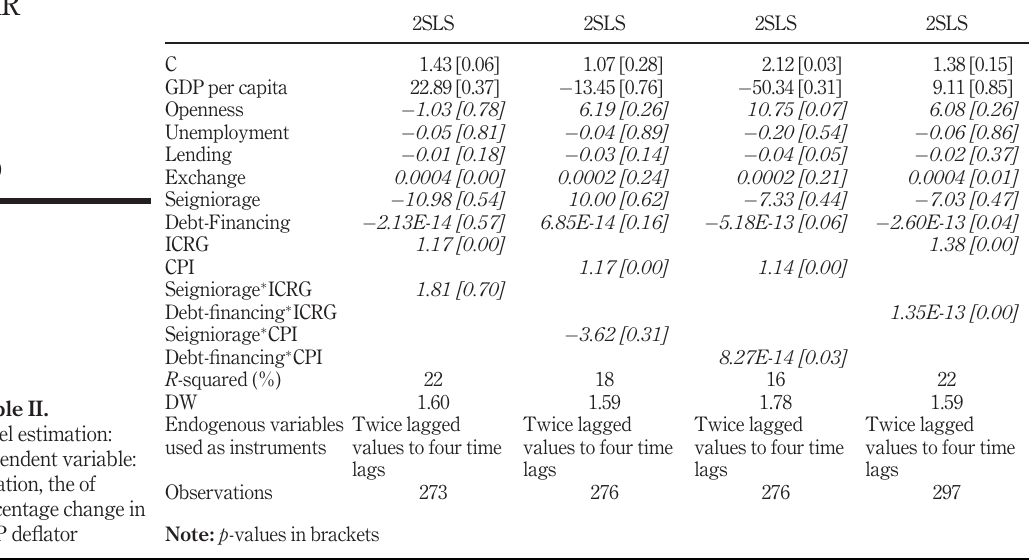
used as instruments Note: p -values in